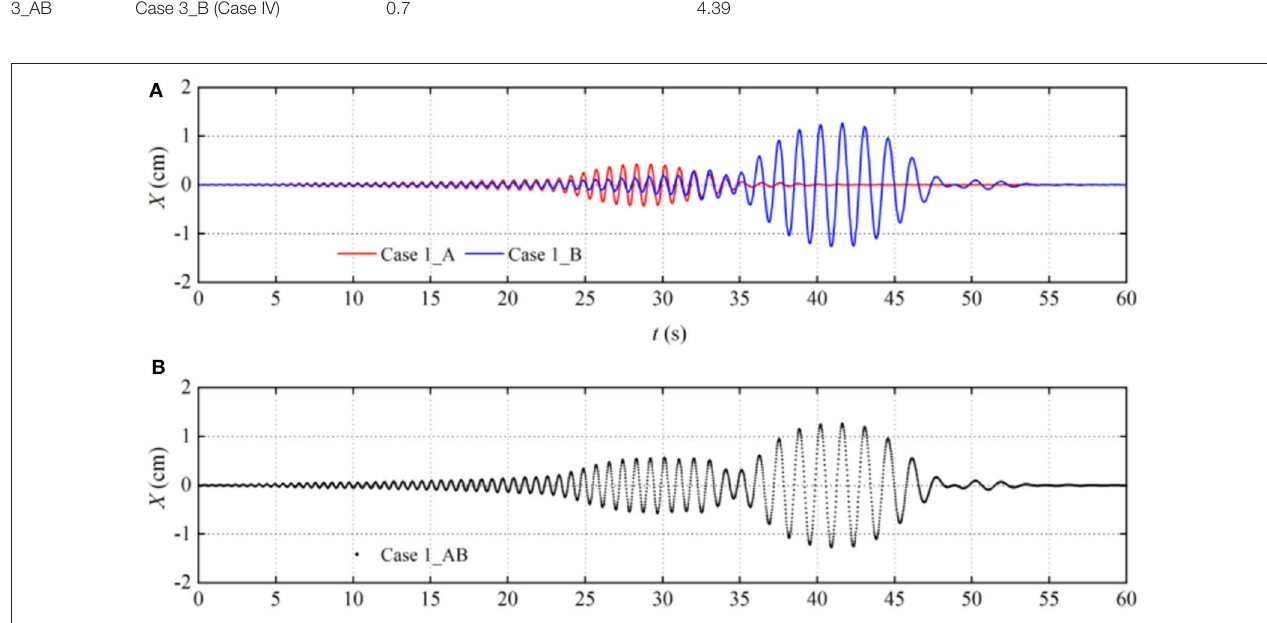
FIGURE 2 | Wavemaker ( x = 0 m) displacement of the (A) independent single wave group focusing and (B) double wave groups focusing for Case 1.